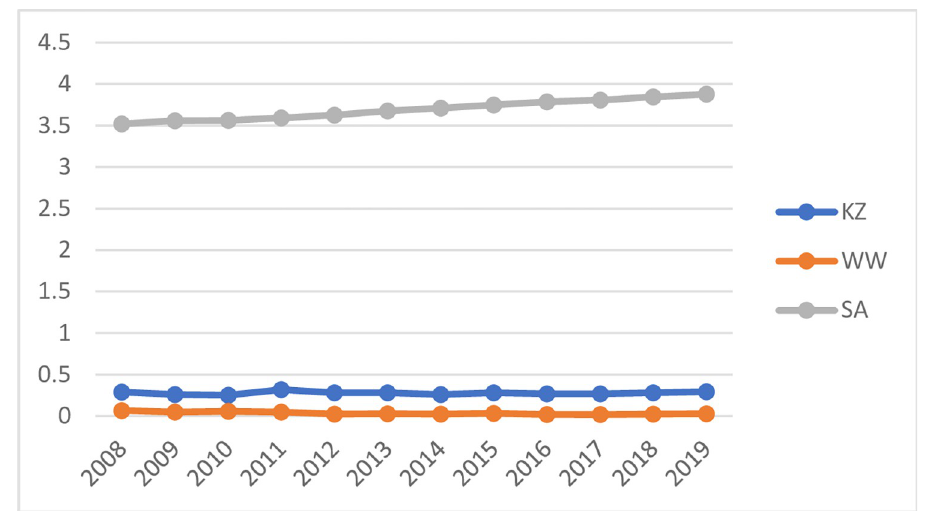
Fig 2. The trend of KZ\WW\SA index over